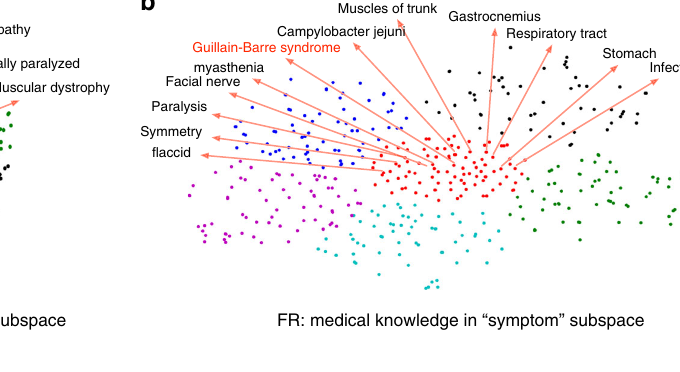
Fast Reading ” process (Supplementary Methods and Supplementary Fig. 9) and then perform “ Deep Reading ” , supervised by the correct answer, over the digest